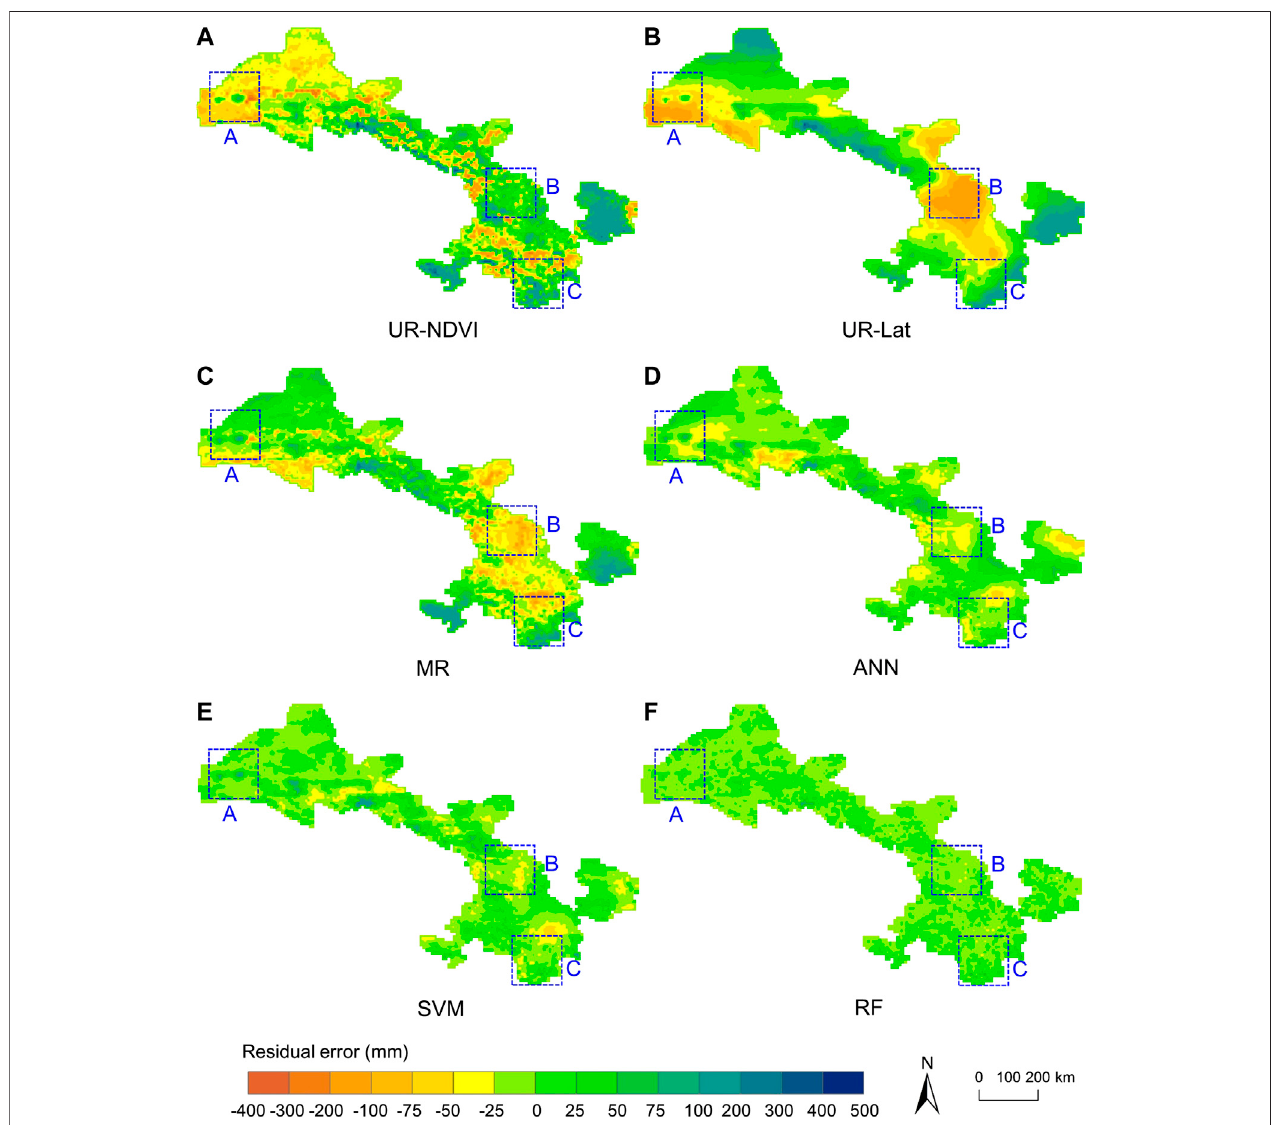
FIGURE 6 | Interpolated residual errors at 1 km spatial resolution in 2015: (A – F) UR-NDVI, UR-Lat, MR, ANN, SVM, and RF.